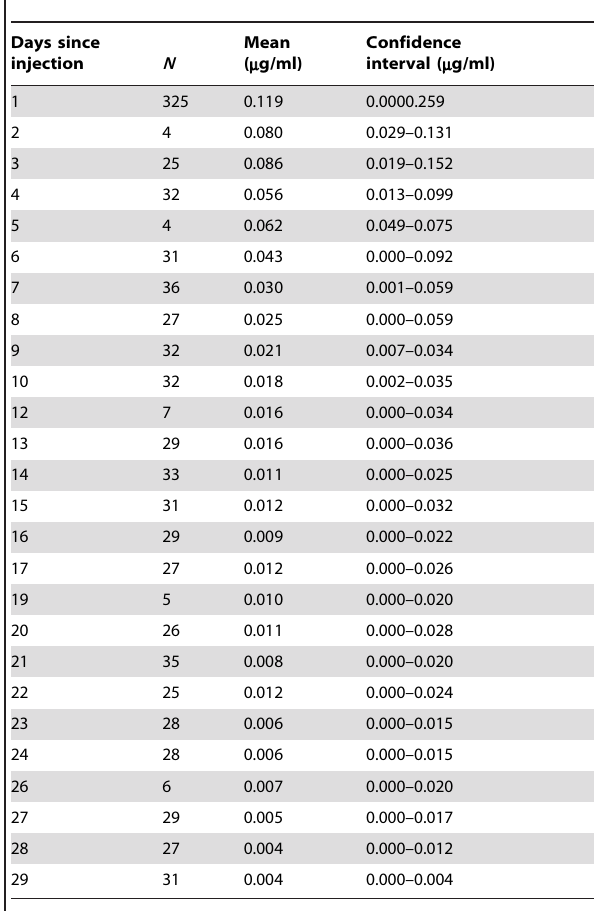
Table 3. Mean serum penicillin G levels and 95% confidence intervals for days since